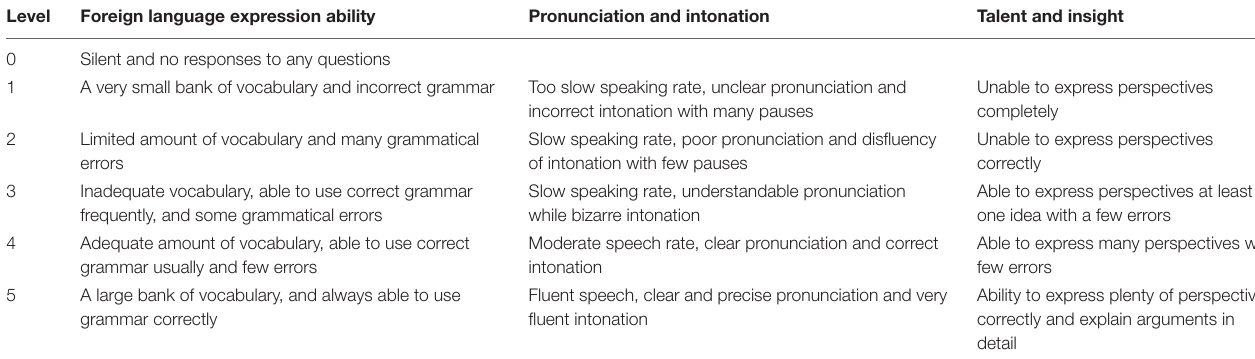
TABLE 2 | Definitions of grading